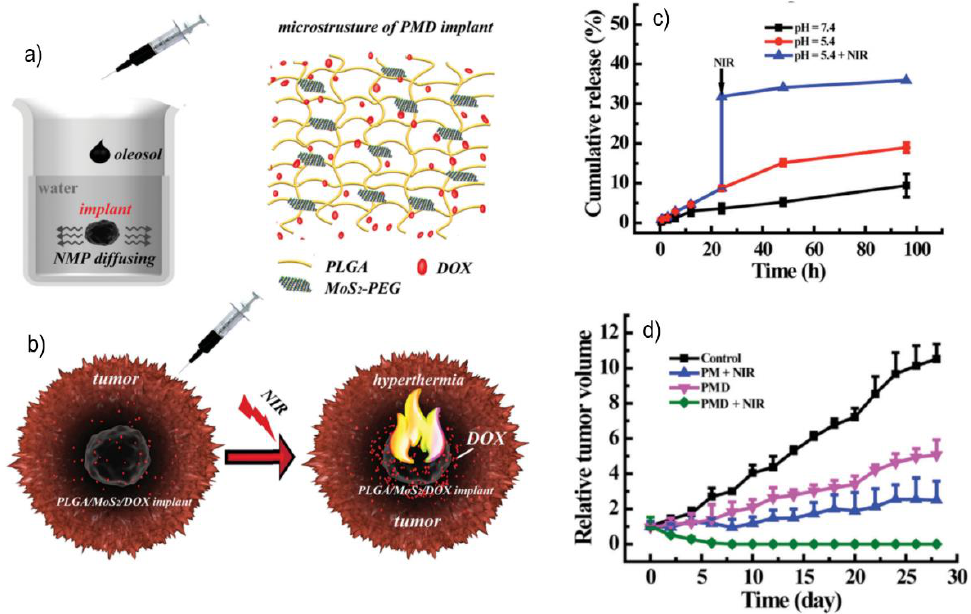
Figure 4. ( a ) Schematic representation of the solidification process when in contact with water and the microstructure of the implant; ( b ) diagram of the implant application in vivo, injection of the implant on the tumor which induces tissue hyperthermia upon NIR exposure; ( c ) DOX release profile under three different conditions (pH = 7.4; pH = 5.4; pH = 5.4 + NIR); ( d ) tumor volume under different treatments (control; PLGA/MoS 2 (PM); PLGA/MoS 2 /DOX oleosol (PMD); PMD + NIR). Reproduced with permission from [81] © 2015 WILEY-VCH Verlag GmbH & Co. KGaA, Weinheim.